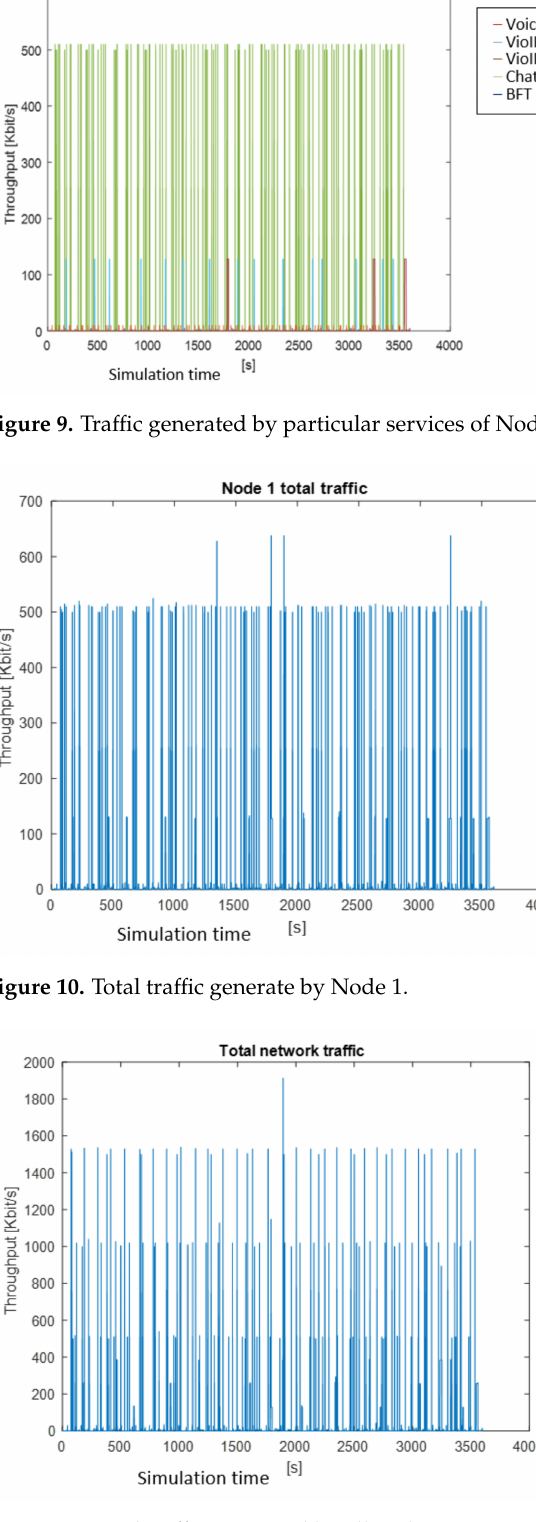
Figure 11. Total traffic generated by all